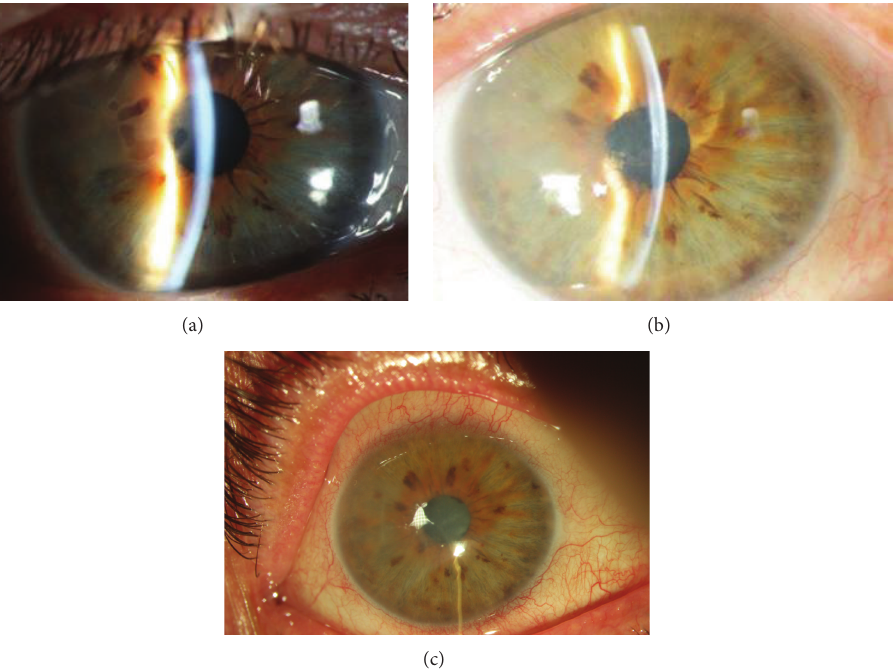
Figure 1: (a) Case 1: slit lamp biomicroscopy picture of the right eye before CXL. (b) Case 1: slit lamp biomicroscopy picture of the right eye 12 months after CXL. (c) Case 1: slit lamp biomicroscopy picture of the right eye 3 months after repeat